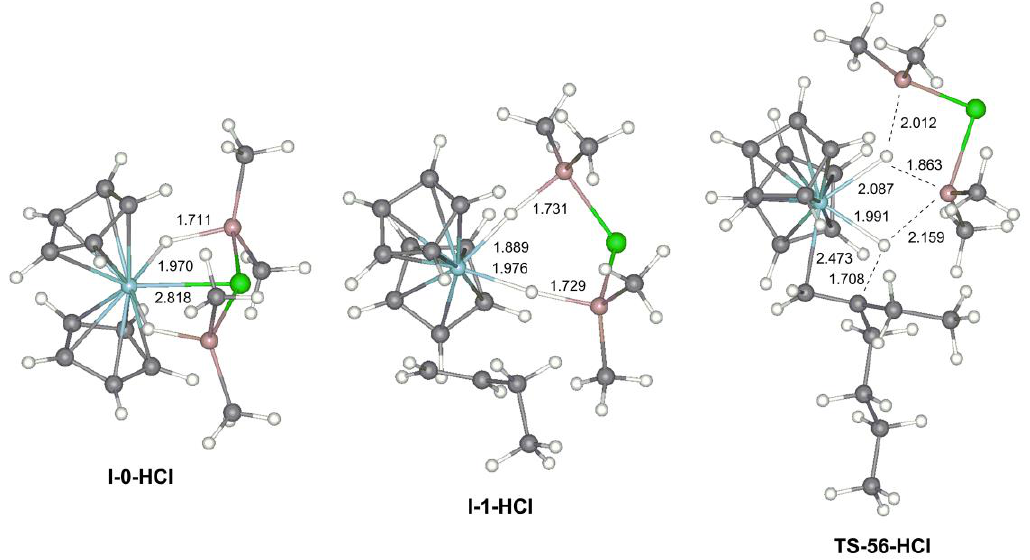
Figure 3. Optimized geometries of the stationary points I-0-HCl (left), I-1-HCl (center) and transition state TS-56-HCl (right).